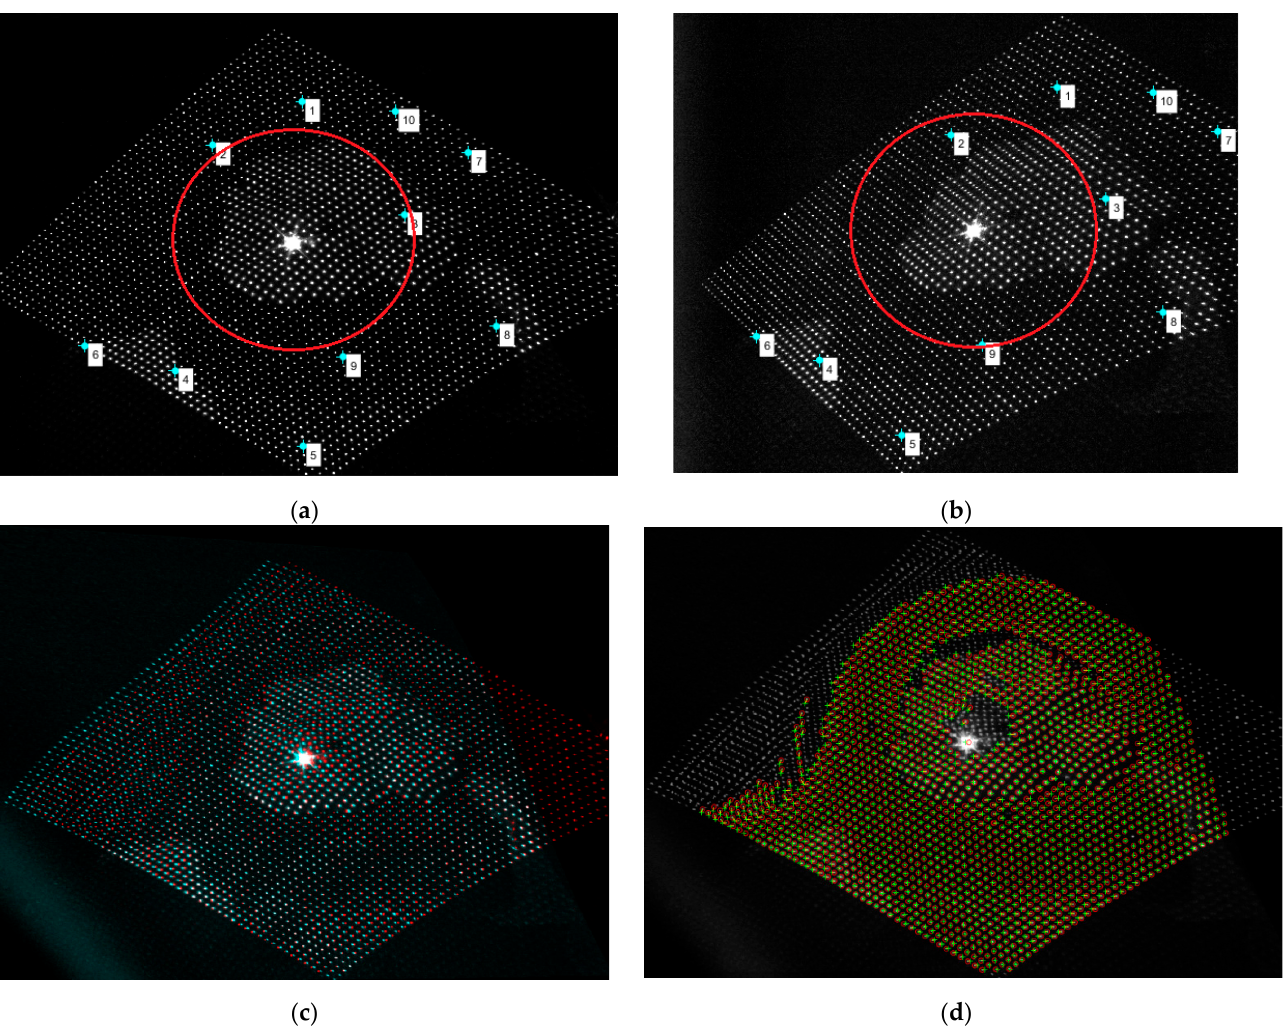
Figure 11. Set of 10 matching points (variant W1) with the best adaptation: ( a ) Left measurement image; ( b ) right measurement image; ( c ) anaglyph created by overlapping the right image after transformation onto the left image; ( d ) correctly matched markers—points in yellow and red (the red circle marks the area around the center of the marker grid delimited by a circle with radius R = 30 mm).